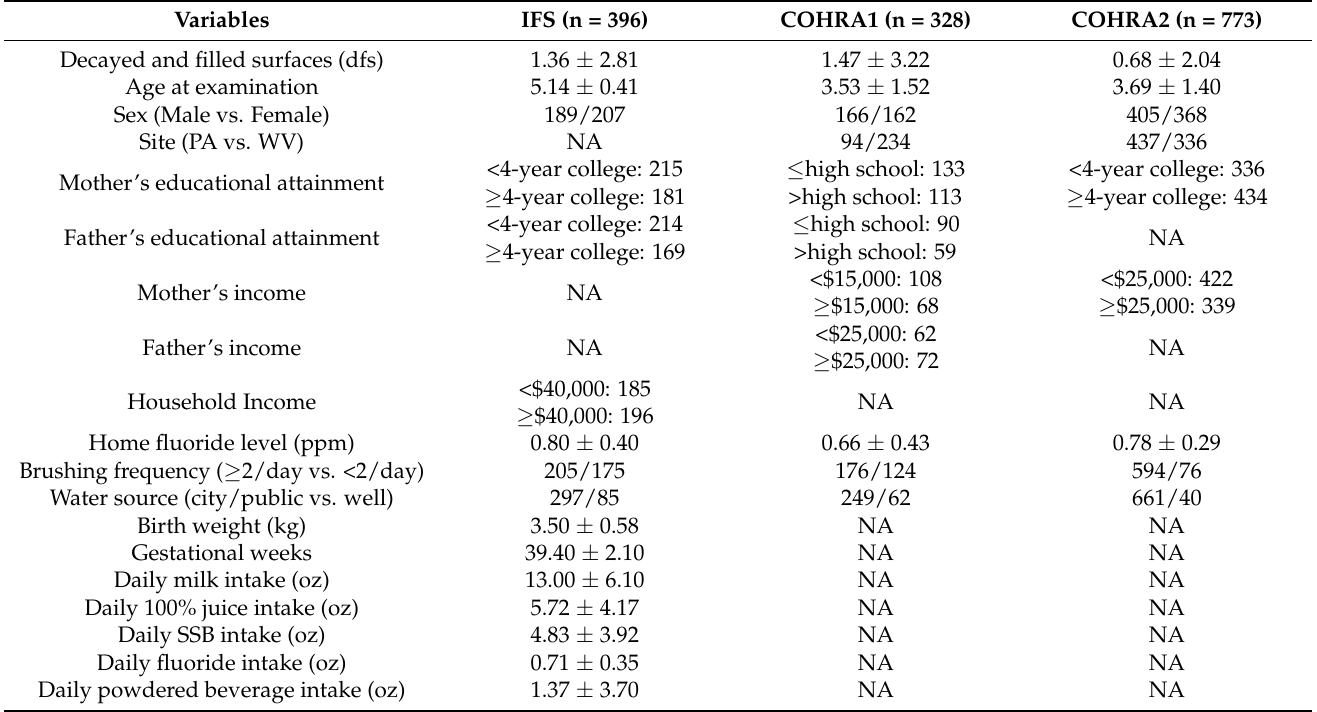
Table 1. Basic characteristics of study samples in IFS, COHRA1, and